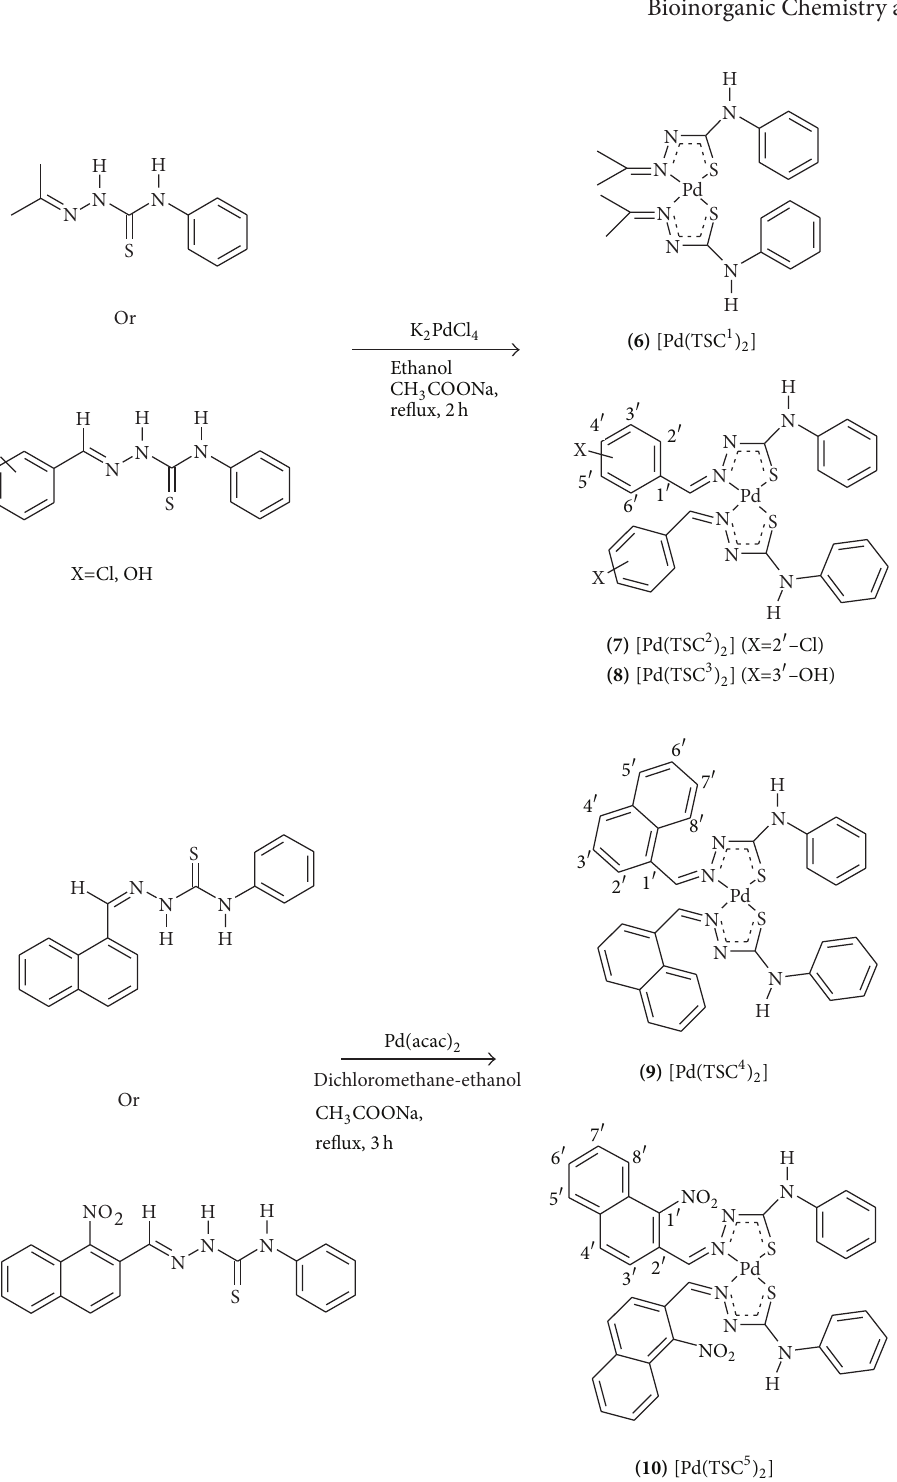
Scheme 2: Synthesis of palladium(II) bis-chelate complexes of acetone, benzaldehyde, and naphthaldehyde thiosemicarbazone